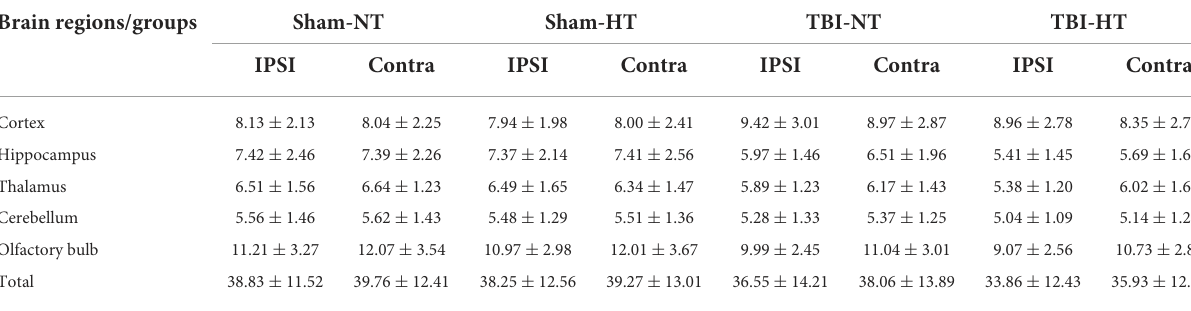
TABLE 3 Quantitative analysis of AQP 4 expression in TBI with hypothermia or normothermia. Brain regions/groups Sham-NT Sham-HT TBI-NT IPSI Contra IPSI Contra